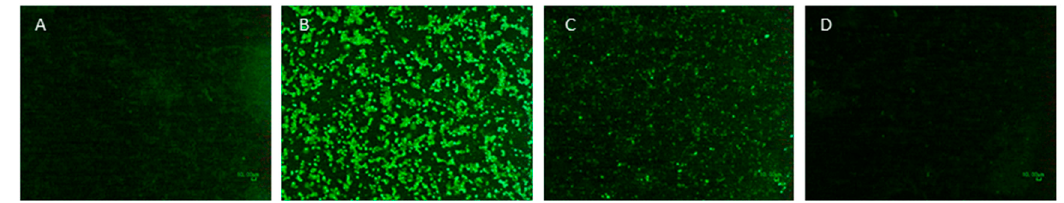
Figure 3. Immunofluorescence assay (IFA) images of Vero cells inoculated with Ebola Zaire virus (EBOV). Anti ‐ EBOV antibody bound virus particles and was in turn bound by fluorescein ‐ labeled goat ‐ anti rabbit. Each image shows fluorescence detected after 10 days in culture: ( A ) negative control, cells only; ( B ) positive control, cells 10 days after inoculation with virus that was exposed to UV ‐ A light but not treated with 4 ′‐ aminomethyl ‐ trioxsalen (AMT); ( C ) cells 10 days after inoculation with inactivated virus, fluorescent foci indicate internalized virus particles; and ( D ) cells after inoculation with inactivated virus and subculture four times, for a total of 40 days incubation.